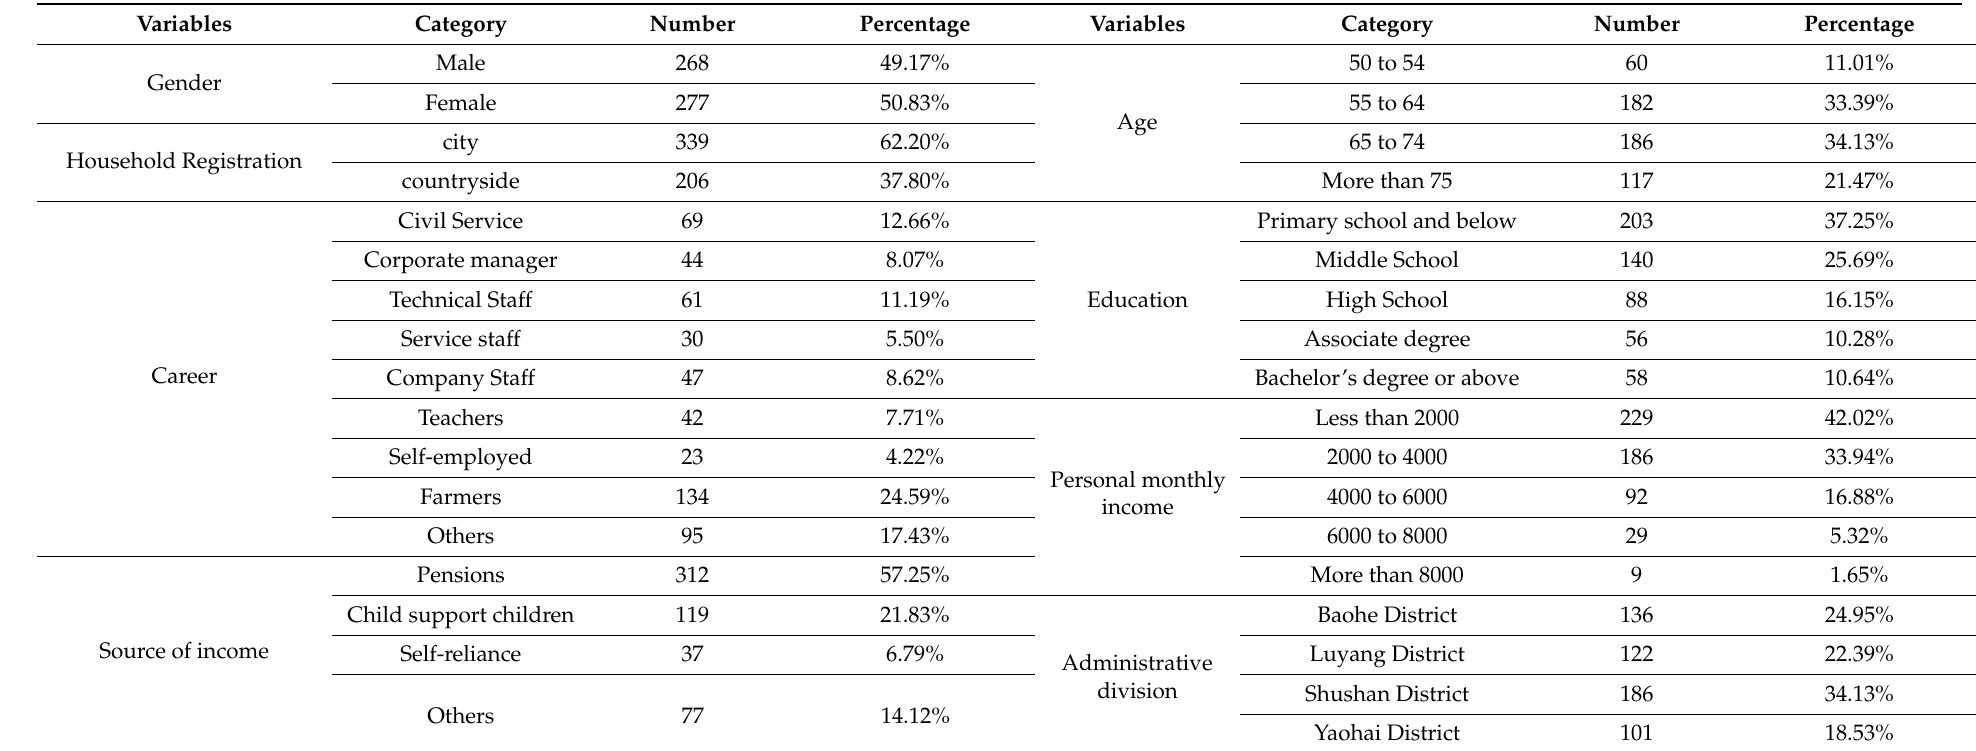
Table 2. Profile of the